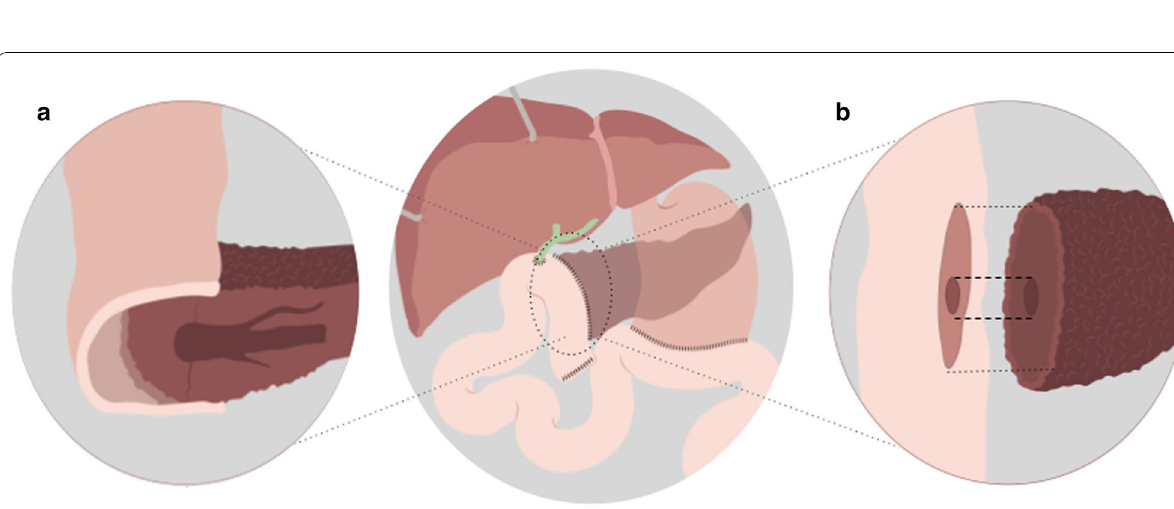
Fig. 2 Pancreaticojejunostomy. Main surgical techniques: ( a ) Invagination ( b )